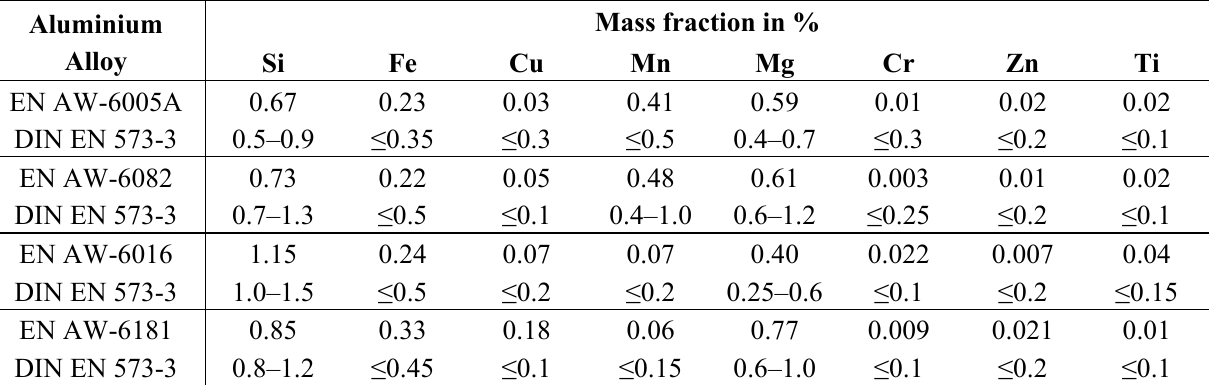
Table 1. Mass fraction of alloying elements of the investigated materials in %.